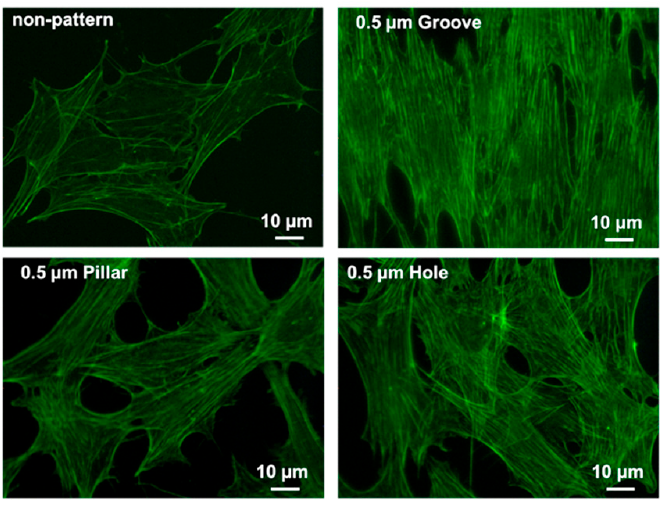
Figure 7. CLSM images of actin filaments of MC3T3-e1 cells on non-patterned or patterned PLGA membranes.